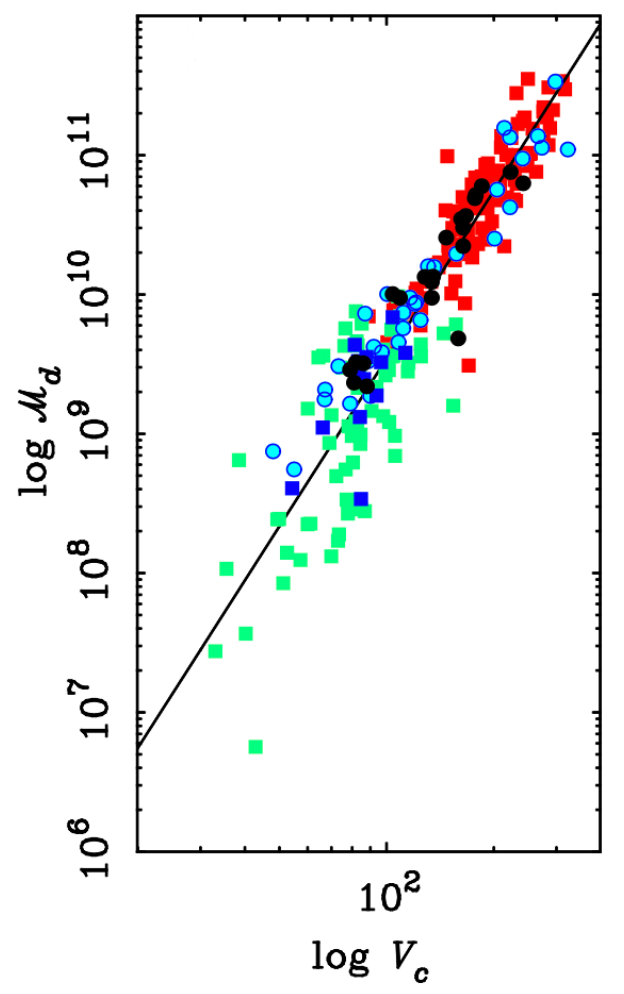
Figure 2. Baryonic Tully-Fisher Relation (BTFR): total baryonic disk mass of galaxies against the rotation velocity V c . Circles and squares represent the data derived from [138] (red), [139] (black), [137,142] (green), [140] (light blue) and [141] (dark blue). The black solid line shows an unweighted linear fit. The figure is reproduced from